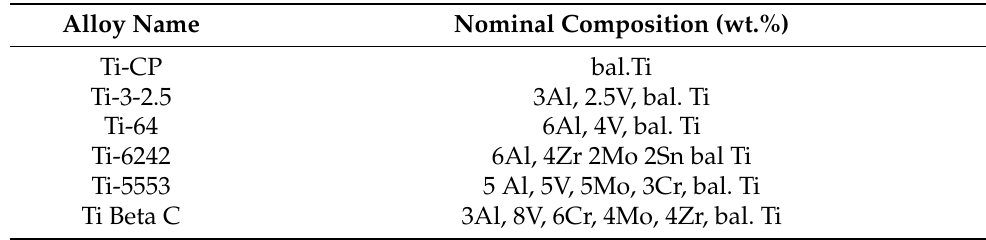
Table 1. Titanium alloys and their corresponding nominal compositions (wt.%).